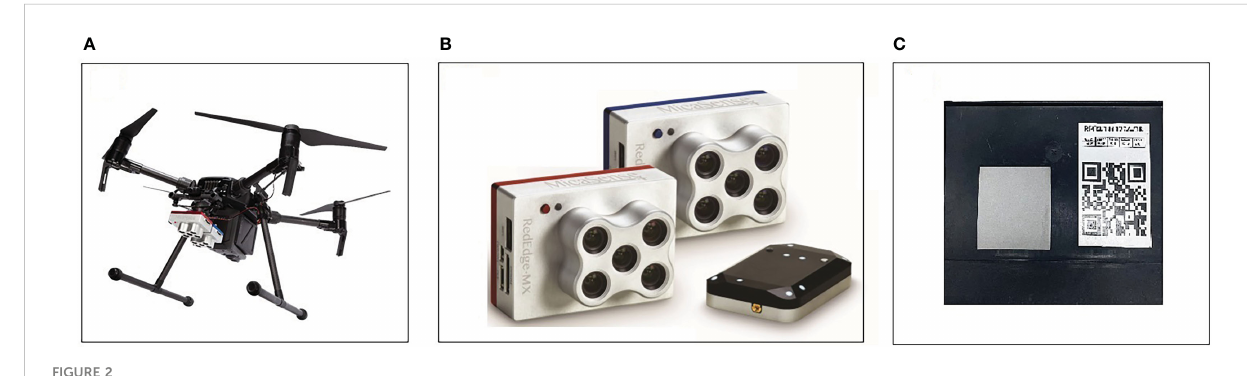
FIGURE 2 UAV near ground remote sensing platform. (A) Four rotors UAV (B) Multispectral imaging system (C) The calibration panel.